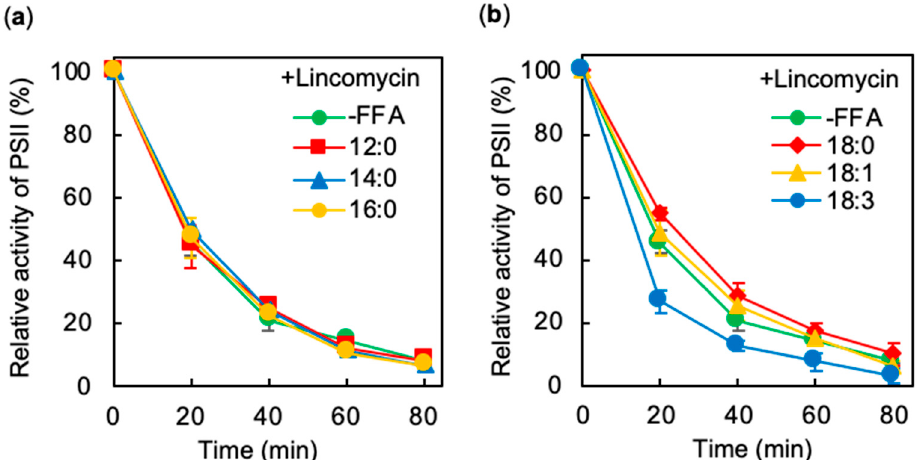
Figure 3. Photodamage to PSII in Synechocystis cells under strong light in the presence of 0.2 mg mL − 1 lincomycin and various FFA. ( a ) Synechocystis cells were incubated at 32 ◦ C under strong light at 1500 µ mol photons m − 2 s − 1 , with ambient aeration, in the absence (-FFA) or presence of 0.1 mM lauric acid (12:0; red squares), myristic acid (14:0; blue triangles), and palmitic acid (16:0; yellow circles). ( b ) Same condition as (a) in the absence (-FFA; green circles) or presence of 0.1 mM stearic acid (18:0; red diamonds), oleic acid (18:1; yellow triangles), and α -linolenic acid (18:3; blue circles). The activity of PSII of the cells was measured at 32 ◦ C in terms of the evolution of oxygen in the presence of 1 mM 1,4-benzoquinone and 1 mM K 3 Fe(CN) 6 . Values are means ± S.D. (bars) of results from three independent experiments.